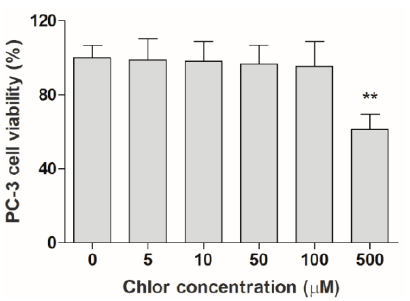
Figure 2. Effect of Chlor on PC-3 cells. Cell viability, after exposure to increasing concentrations of Chlor (5, 10, 50, 100 and 500 µM), was evaluated at 24 h by WST-1 assay. Statistical significance vs. untreated cells: ** p < 0.01.